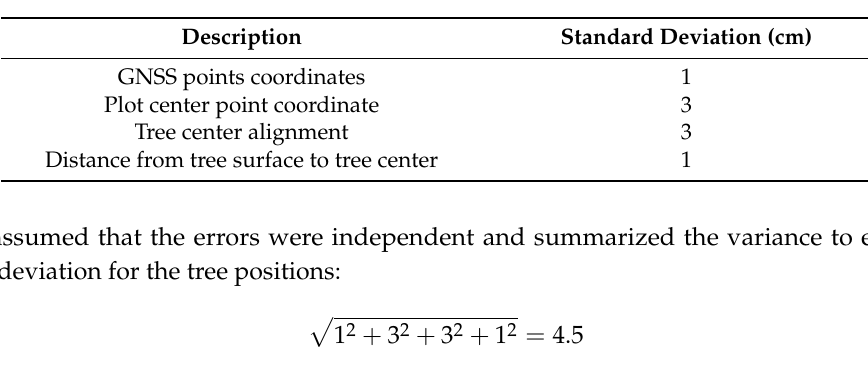
Table 2. Error budget for the tree positions. Standard deviations are approximated based on output from the GNSS post processing software, and inspection of the